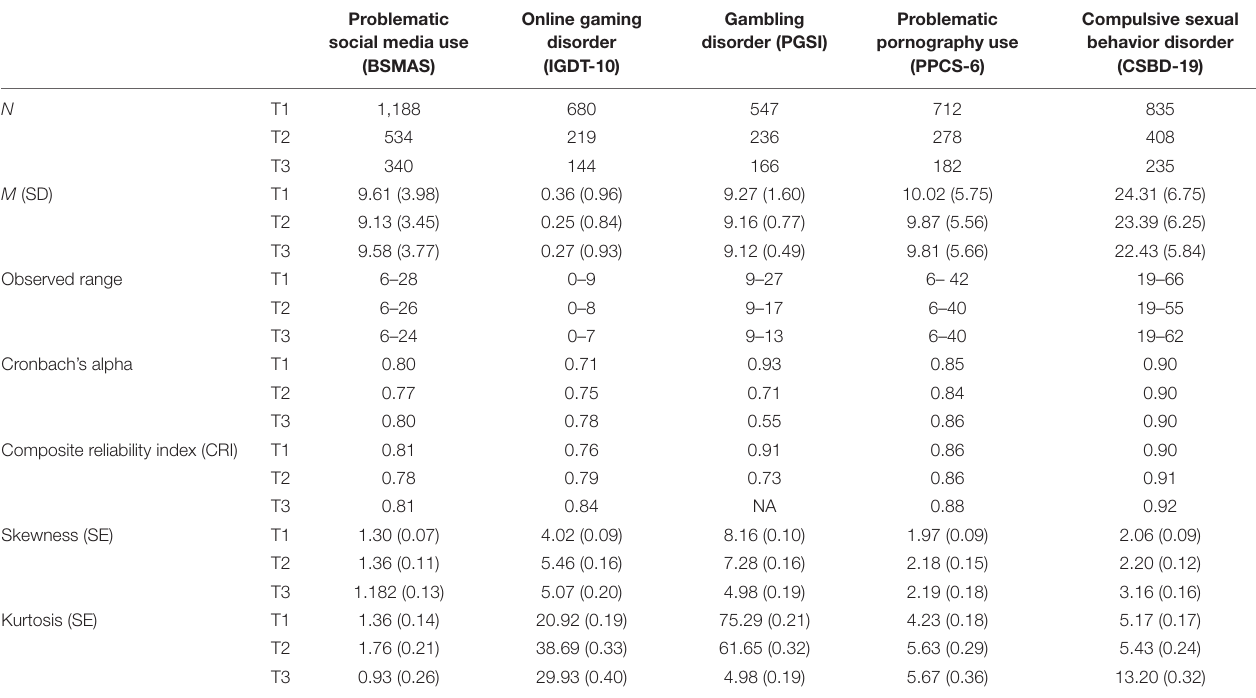
TABLE 1 | Descriptive statistics, normality indices, and psychometric properties of the